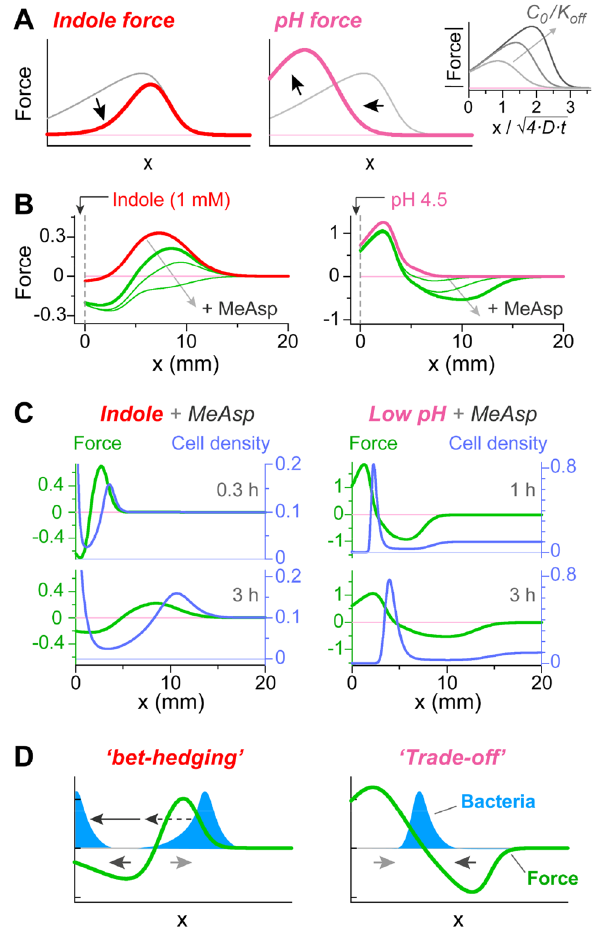
Figure 5. Analysis of the expected chemotactic force fields along the channel and the corresponding bacterial distributions. ( A ) Schematic depiction of the qualitative influence that the properties revealed in Fig. 4 are expected to have on the force profile, compared with its generic form (gray line). Inset —the force profile (in absolute value) corresponding to Eq. 1 with K off being 1, 10, and 100 µM ( K on = 10 mM; C 0 = 1 mM) ( B ) The force profiles obtained from the simulations by fitting the bacterial distributions (see Supplementary text and Fig. S5). Force profiles are shown for indole (left plot, 1 mM) or low pH (right plot, 4.5–7), without MeAsp (red and magenta lines, respectively) or with increasing amount of MeAsp at the source (green lines): 0.1, 0.3, and 1 mM (left plot) or 0.1, 1, and 10 mM (right plot). The MeAsp force have here a negative sign. ( C ) Force profiles (green lines, left scale) and the corresponding bacterial distributions (blue lines, right scale); the left plot corresponds to indole (1 mM) and MeAsp (0.3 mM), and the right plot corresponds to low pH (4.5–7) and MeAsp (10 mM). ( D ) Schematic illustration of the relations between the force and bacterial accumulation, based on